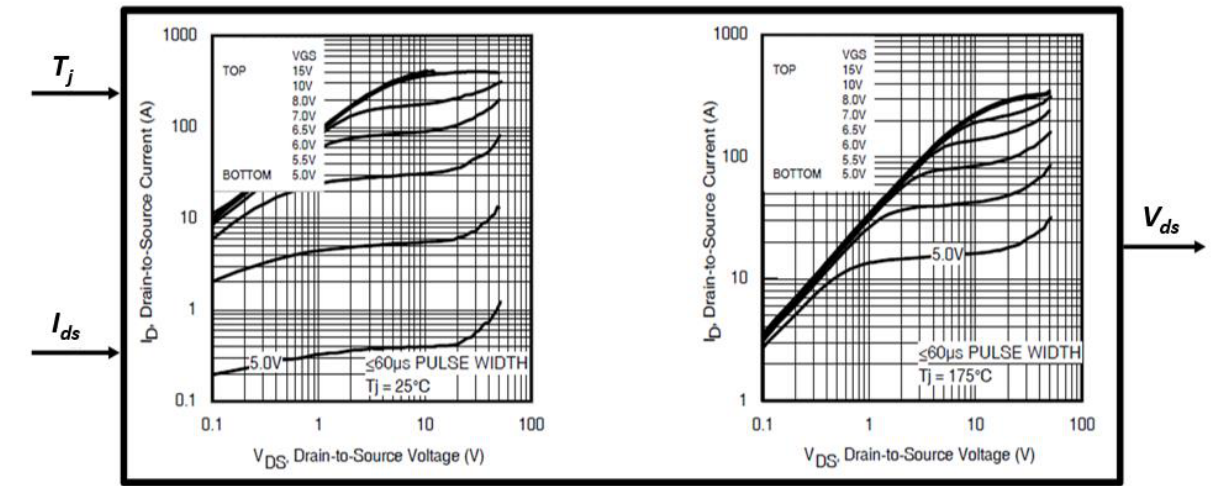
Figure 12. Lookup table to determine V ds of MOSFET.